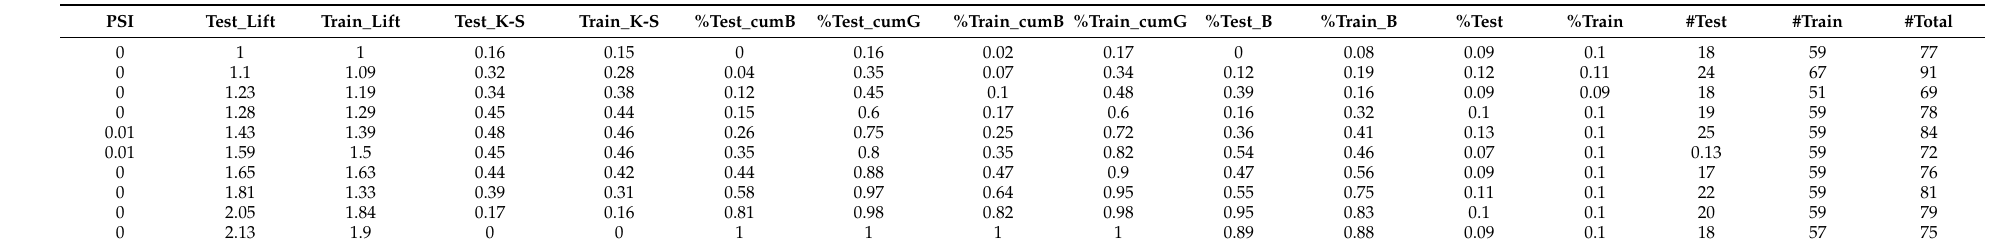
Table 4. Summary of the model validation